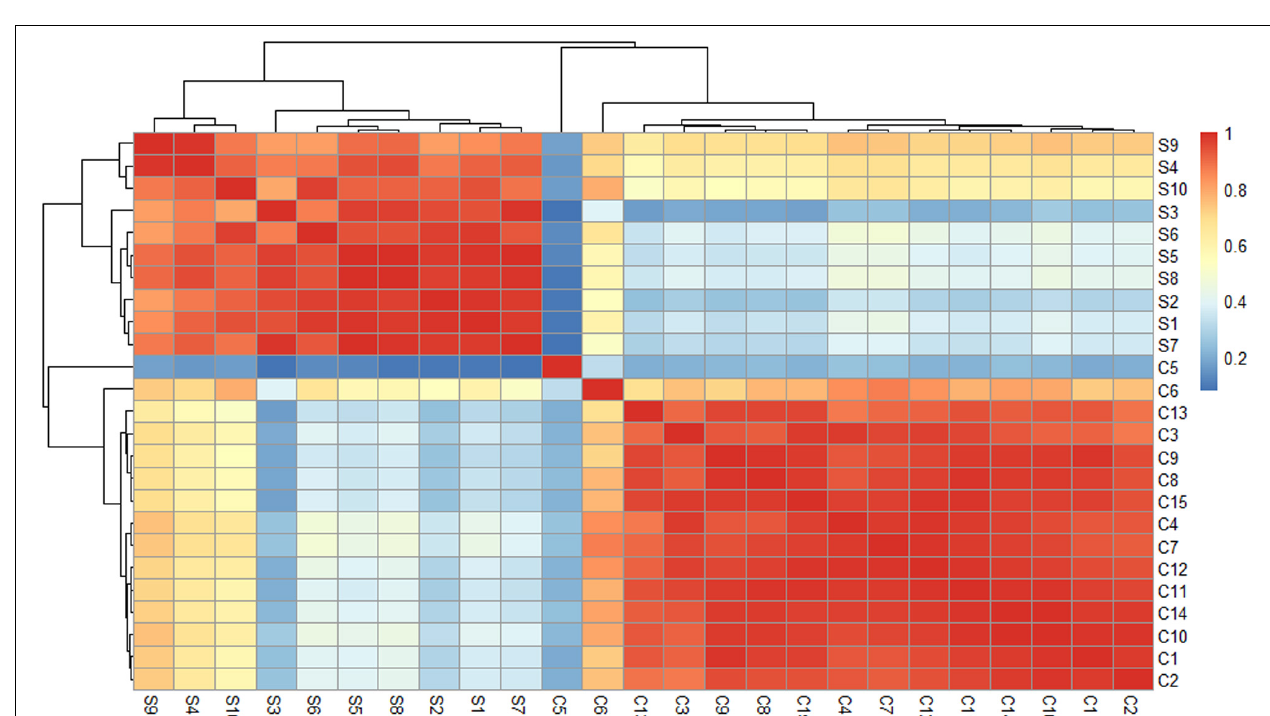
FIGURE 1 | Heat maps of the Pearson’s correlation coefficients for different samples. When the linear relationship between the two variables is enhanced, the correlation coefficient tends to be 1 or –1. A positive correlation tends to be 1, while a negative correlation tends to be –1.